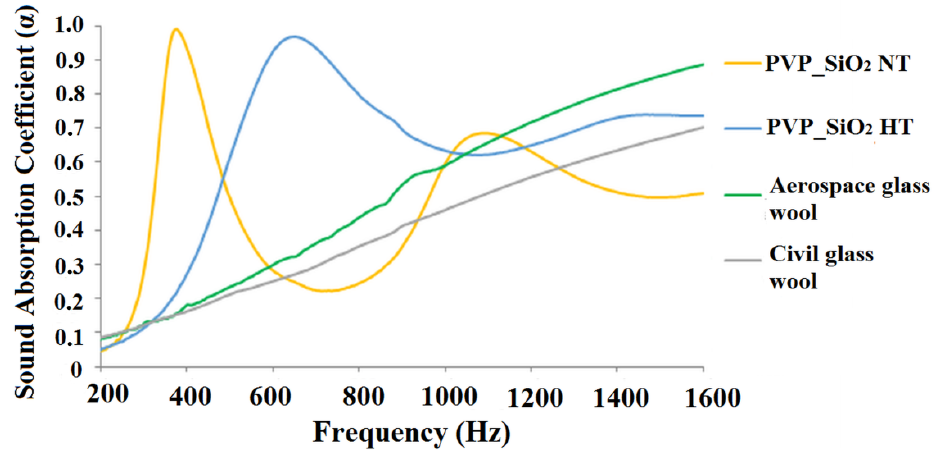
Figure 16. Comparison of the acoustical behaviors of electrospun PVP / silica mats and glass wool samples marketed in civil and aerospace engineering fields of same thickness (2.5 cm).